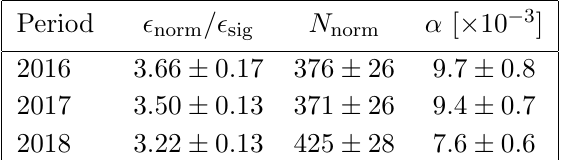
hypothesis, m ((cid:4) 0 ) = 6 : 9 GeV =c 2 and (cid:28) ((cid:4) 0 ) = 400 fs. The uncertainties bc bc bc